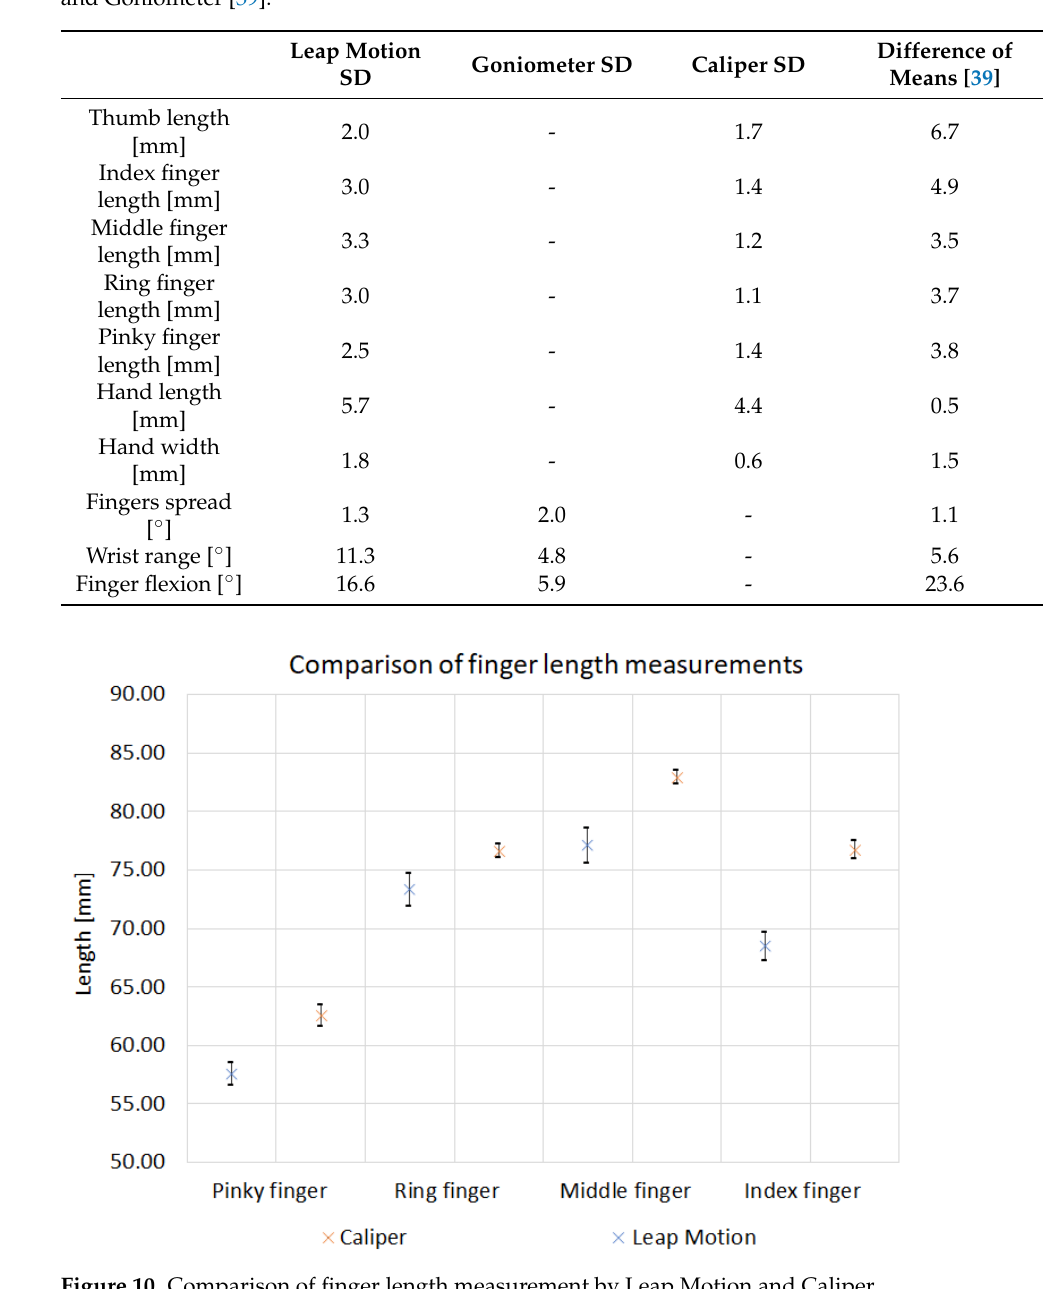
Table 3. Standard deviations (SD) and Difference of Means of measurements by Leap Motion, Caliper, and Goniometer [39].